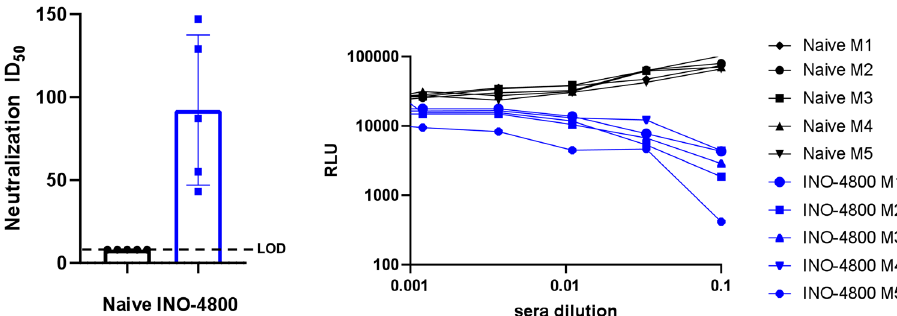
Fig. 4 Neutralizing antibody responses after immunization of INO-4800. BALB/c mice ( n of 5 per group) were immunized twice on days 0 and 14 with 10 µ g of INO-4800. Sera was collected on day 7 post-second immunization and serial dilutions were incubated with a pseudovirus displaying the SARS- CoV-2 Spike and co-incubated with ACE2 – 293T cells. a Neutralization ID50 (mean ± SD) in naïve and INO-4800 immunized mice and b relative luminescence units (RLU) for sera from naive mice (green) and mice vaccinated with INO-4800 (red) as described in “ Methods ” .